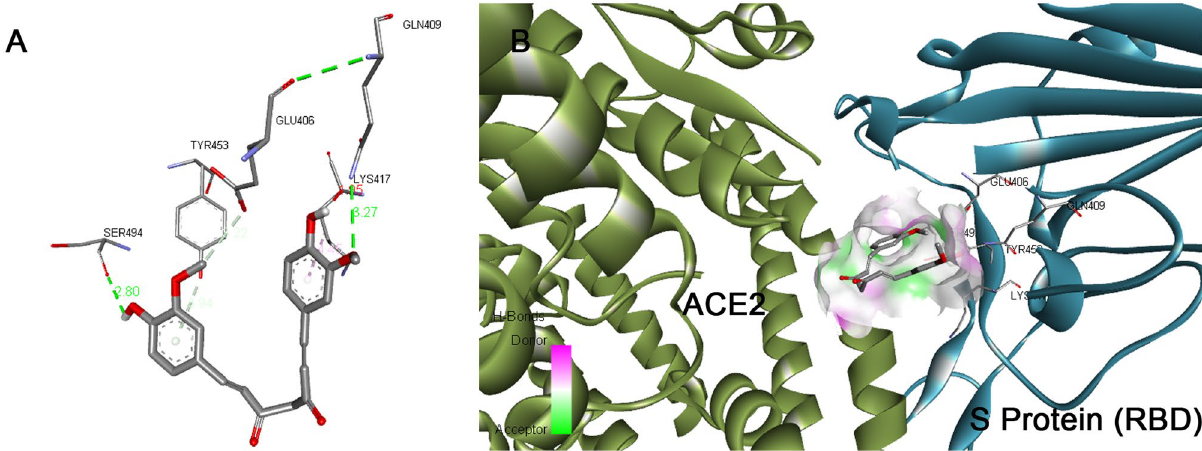
Figure 5. Docked pose of curcumin in the interface of RBD/ACE2-complex. ( A ) Participating amino acids in the interaction of curcumin and RBD/ACE2-complex, ( B ) Several bonds involved in the interaction between curcumin and RBD/ACE2-complex. This figure was produced using Discovery Studio Visualizer (http://accel rys.com/produ cts/colla borat ive-scien ce/biovi a-disco very-studi o/visua lizat ion-downl oad.php).